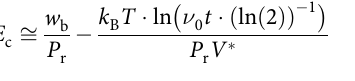
Fig. 1d. Varying E i, k results in hysteresis loops with the center shifted away from E i = 0. In the Preisach plane, this corresponds to moving parallel to the blue diagonal in Fig. 1d.